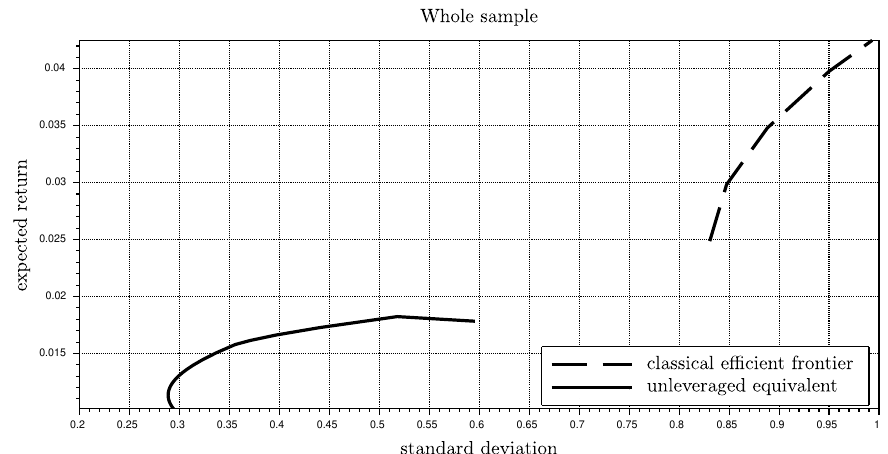
Figure 3. Classical efficient frontier and unleveraged equivalent portfolios. S&P sectors from 1990 to